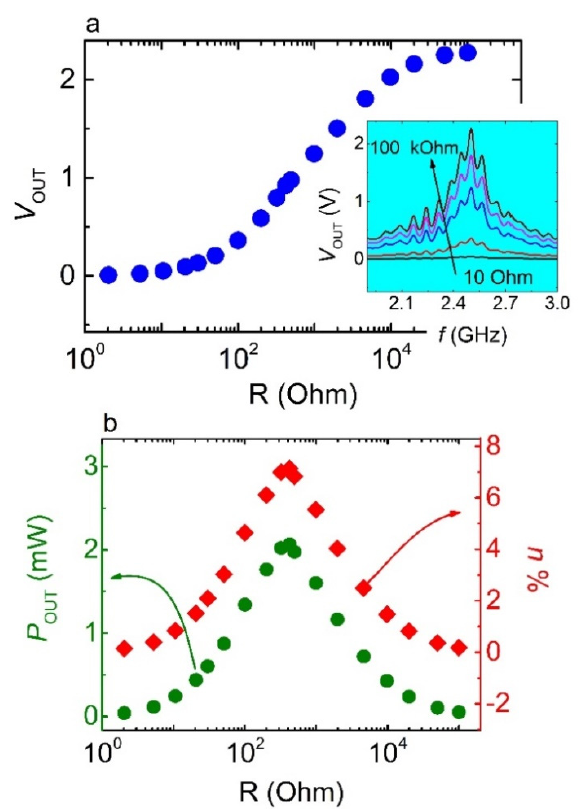
Figure 7. ( a ) Output voltage vs. resistance load, for the Ag/PLA MS, blue inset. Output voltage as a function of frequency for selected resistance loads, i.e., 5 Ohm (black line), 100 Ohm (red line), 500 Ohm (blue line), 5 kOhm (magenda line), and 100 kOhm (dark green line); ( b ) output power as a function of resistance load (green circles) and efficiency vs. resistance (red rhombs). A clear maximum is obtained for R ~400 Ohm.